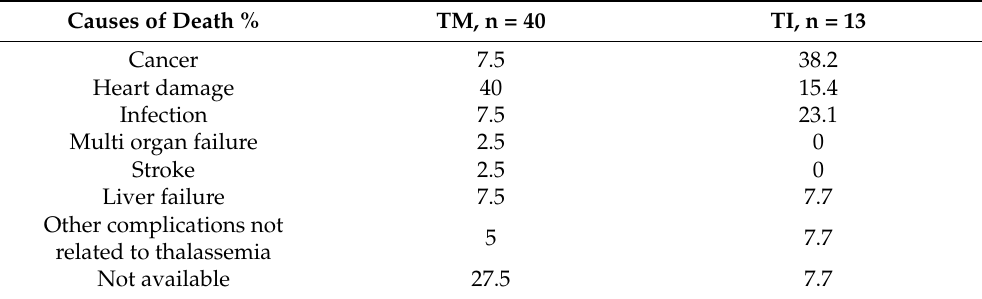
Table 1. Death in thalassemia major (TM) vs. thalassemia intermedia (TI) patients from Vitrano A et al.